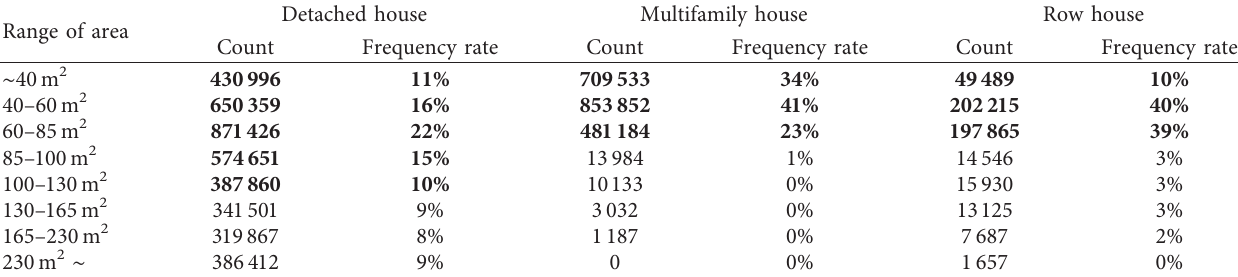
Table 3: Derivation of floor area range through statistical analysis (KOSIS,